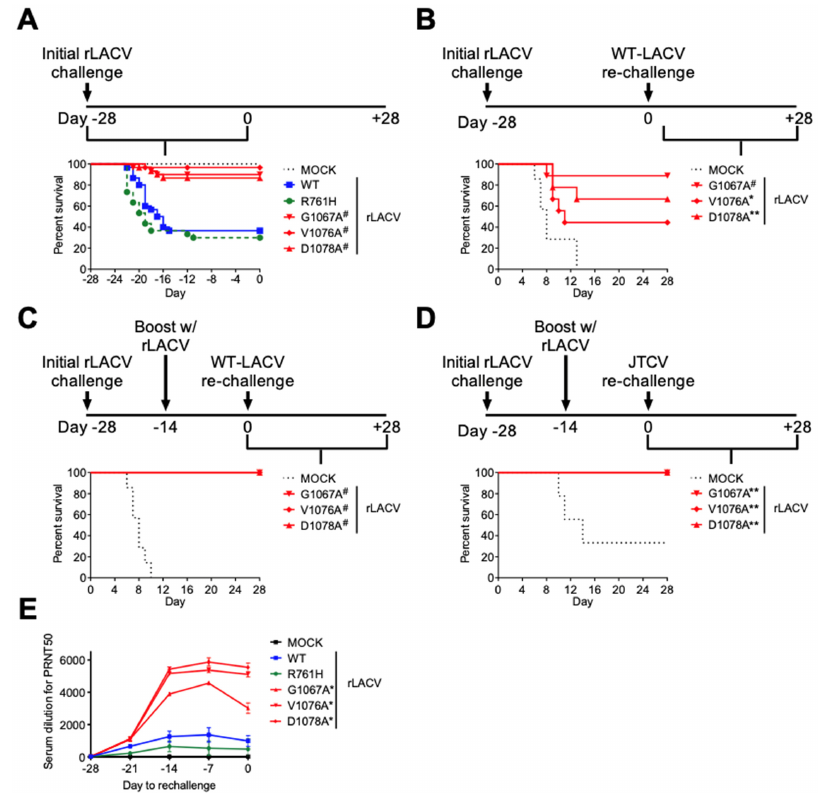
Figure 5. Fusion peptide domain mutant rLACVs are less neuroinvasive and protect against subsequent WT-LACV rechallenge. ( A ) Three-week-old mice were inoculated intraperitoneally with 1000 PFU of rLACV-WT, the tryptic site mutant (rLACV-R761H), or the fusion peptide domain mutant rLACVs (G1067A, V1076A, and D1078A). The mice challenged with the fusion peptide domain mutants had a significantly increased survival rate compared to rLACV-WT (Log-rank (Mantel–Cox) test; n = 30 per group). ( B ) Three-week-old mice infected with 1000 PFU were challenged 28 days after rLACV inoculation with 100*LD 50 of WT-LACV intraperitoneally. Mice infected with rLACV-G1067A were almost fully protected and mice infected with rLACV-V1076A or rLACV-D1078A were partially protected from lethal WT-LACV challenge. ( C , D ) Three-week-old mice immunized with 1000 PFU of rLACVs were boosted with 1000 PFU of the same rLACV 14 days following initial rLACV challenge. Fourteen days following rLACV boosts, the mice were challenged with 100×LD 50 of ( C ) WT-LACV or ( D ) Jamestown Canyon virus intraperitoneally. Mice immunized and boosted with the fusion peptide domain mutant rLACVs were fully protected from lethal WT-LACV or Jamestown Canyon virus rechallenge. (* p < 0.05; ** p < 0.01; # p < 0.001; Log-rank (Mantel–Cox) Test). ( E ). Neutralizing antibodies measured by PRNT 50 .